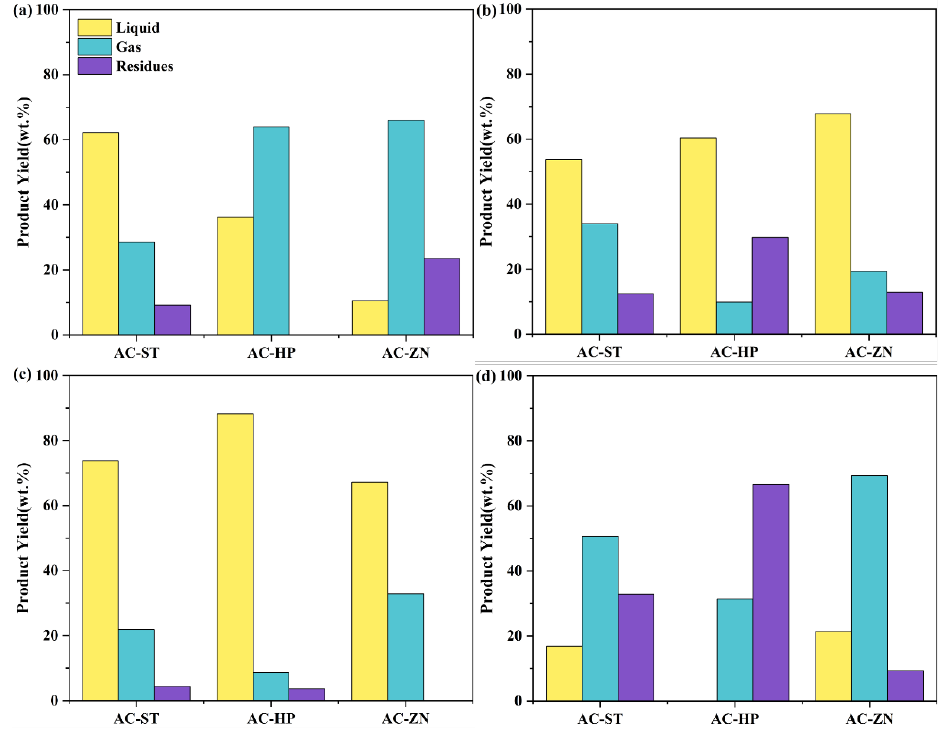
Figure 4. Product yields of ( a ) LDPE, ( b ) PP, ( c ) PS, ( d ) PET under different carbons.